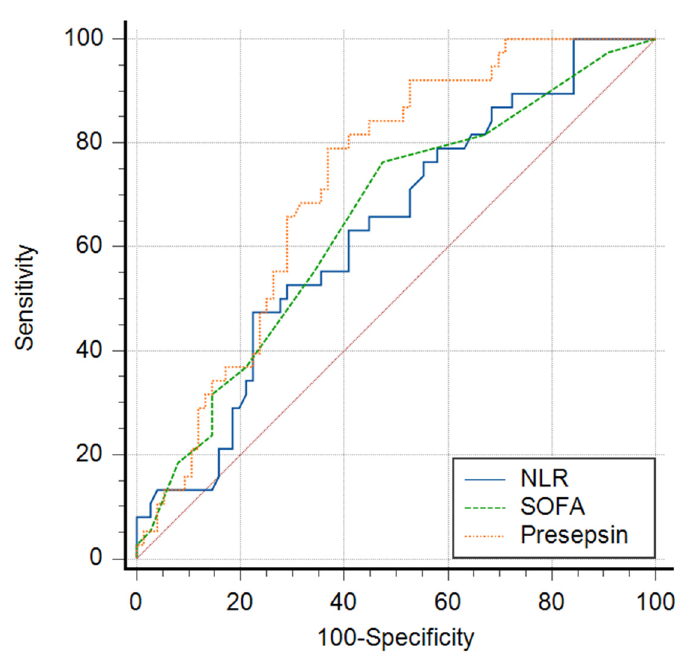
Figure 3. ROC curves comparison for NLR, SOFA score, and presepsin in septic shock. Data are presented as ROC curve for each parameter and 0.5 AUC line.